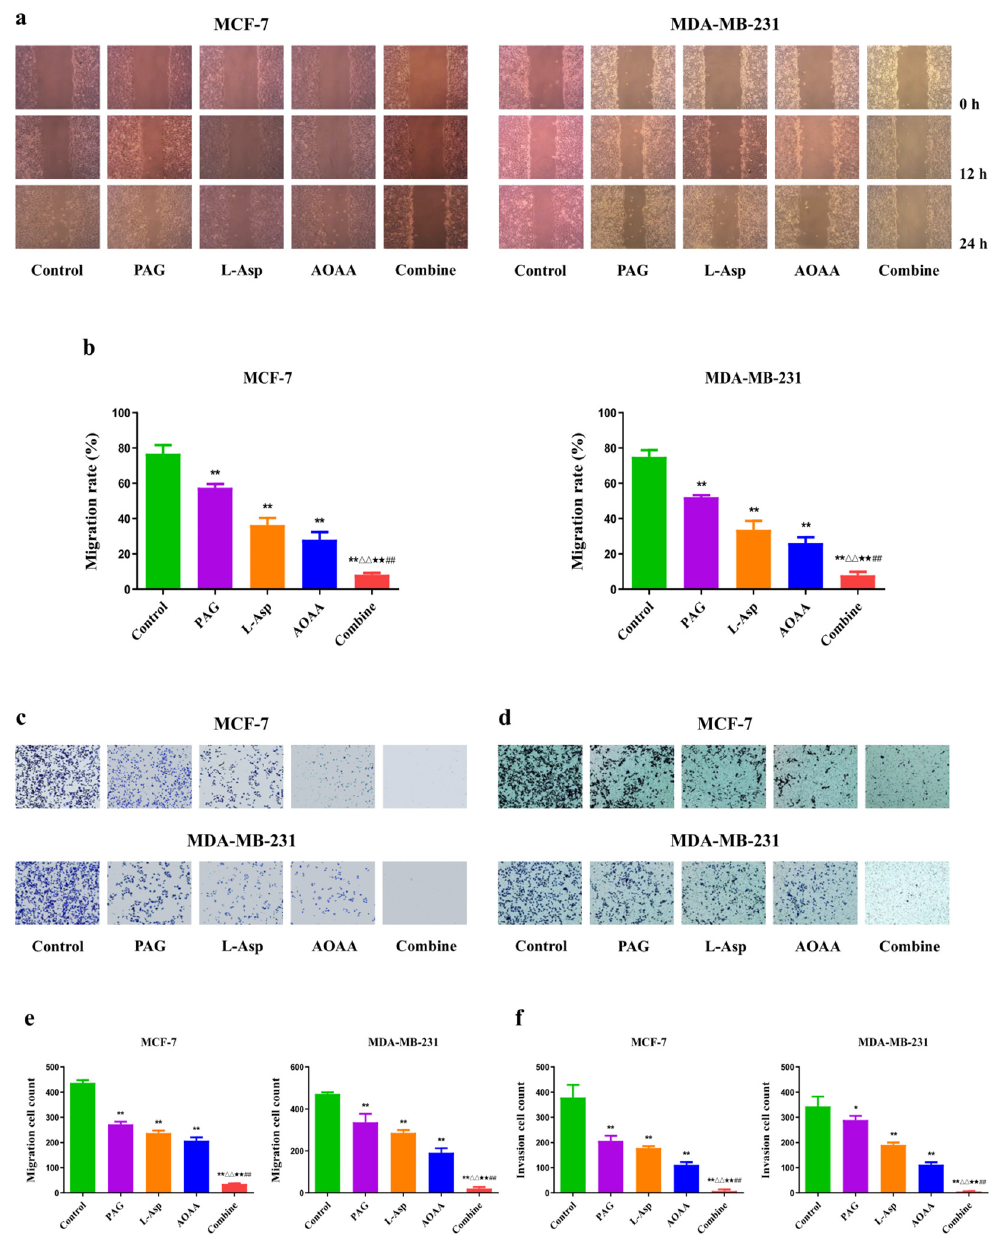
Figure 2. Effects of PAG, AOAA, and L-Asp on the migration and invasion of human BC cells. ( a ) Cell migration was measured by wound-healing assay (original magnification × 100). ( b ) The number of the migrated cells was calculated. ( c , d ) Transwell assay was performed to assess the migration and invasion of BC cells (original magnification × 200). ( e , f ) The number of the migrated and invasive cells was calculated. The experiments were performed in triplicate. Data are presented as mean ± SEM. ** p < 0.01 compared with the control group; △△ p < 0.01 compared with PAG group; ★★ p < 0.01 compared with AOAA group; ## p < 0.01 compared with L ‐ Asp group.